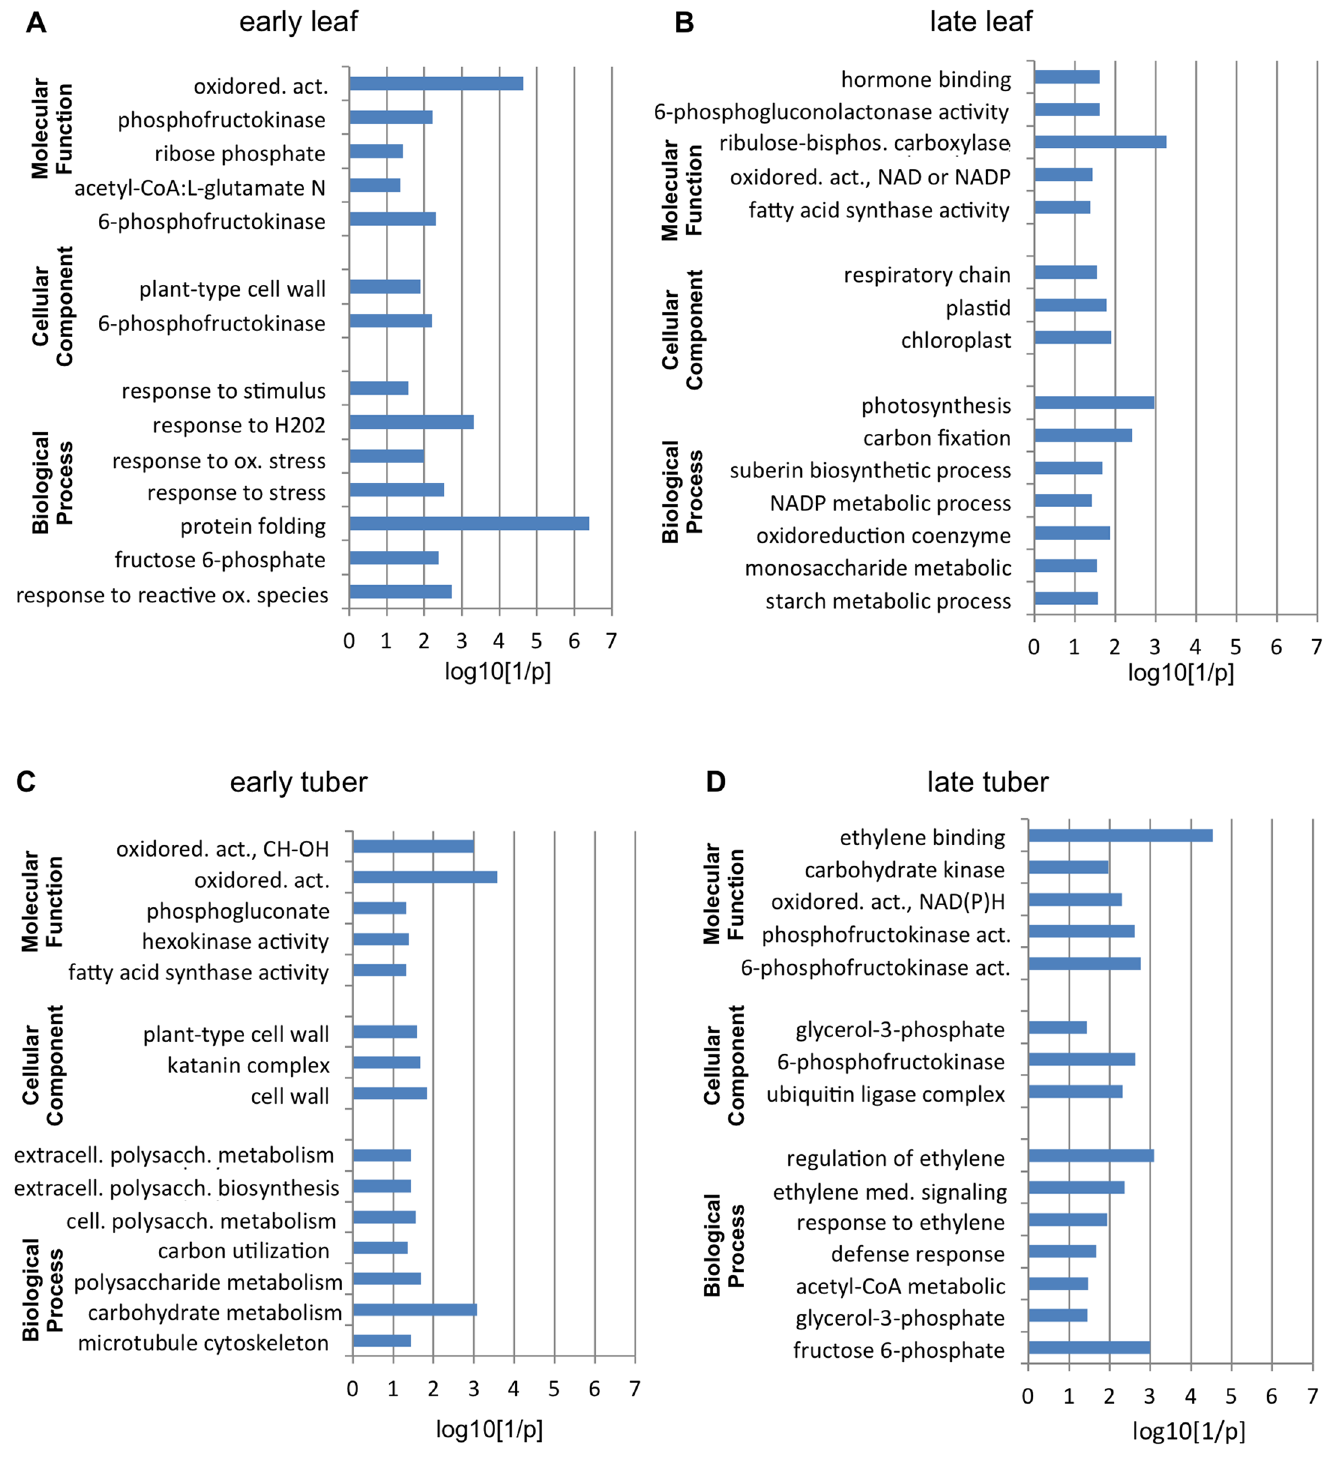
Fig 3. Representation of GO term enrichment. Selected GO term enrichments are visualized in early (A) and late (B) leaf samples. Figs (C) and (D) show GO term enrichment for early and late tuber samples, respectively. Categories are indicated on Y axis, log10[1/p] is on the X-axis where p is the p-value of the